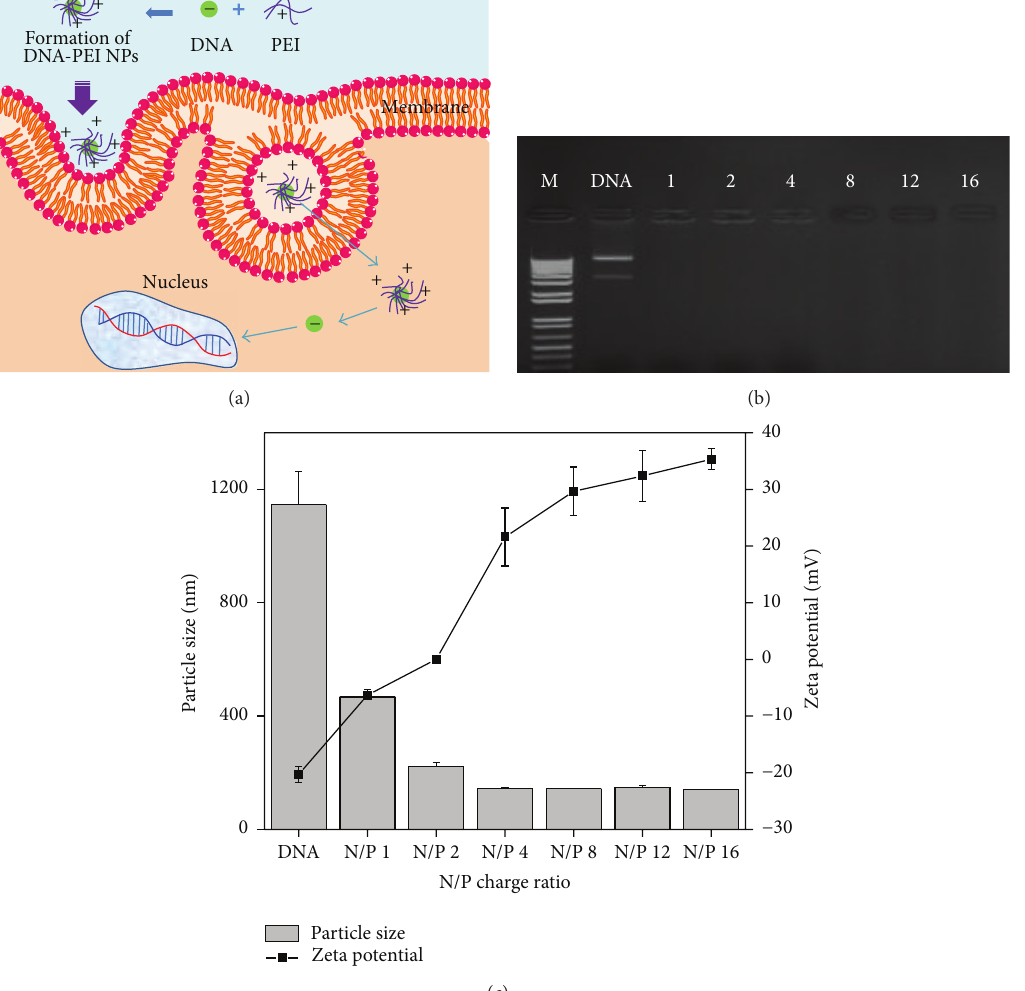
Figure 2: (a) Schematic diagrams of endocytosis using DNA-PEI NPs and the results of (b) electrophoresis on a 1.2% agarose gel and (c) particle sizes and zeta potentials of the DNA-PEI